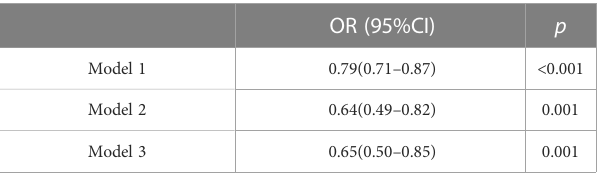
Sarcopenia ( − ) Sarcopenia (+) Sarcopenia (-) Osteoporosis ( − ) Osteoporosis ( − ) Osteoporosis (+)